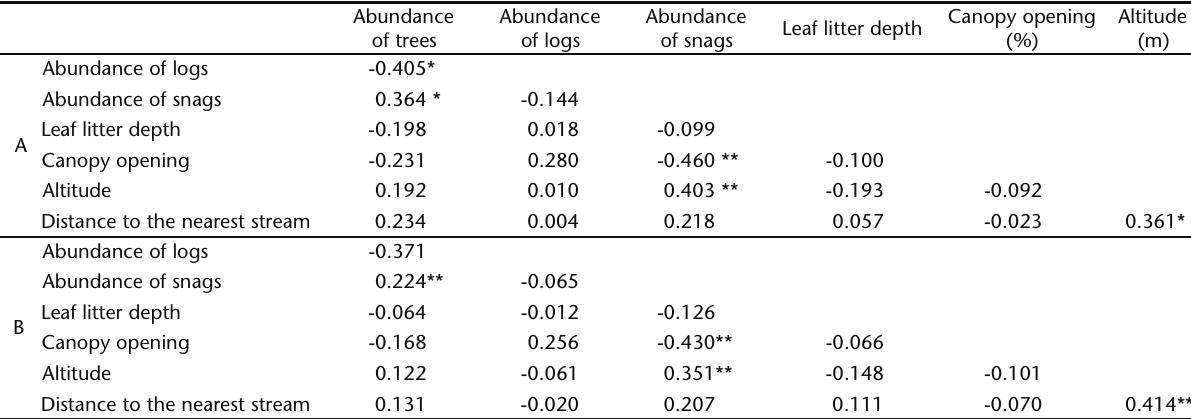
Table II. (A) Pearson correlation matrix for the forest structure components recorded in areas with G. hardyi along the 18 transects of 8 km length at Ducke Reserve, Central Amazon. (B) Pearson correlation matrix for the forest structure components recorded in 120 areas, 60 of them with and 60 without G. hardyi (see methods).